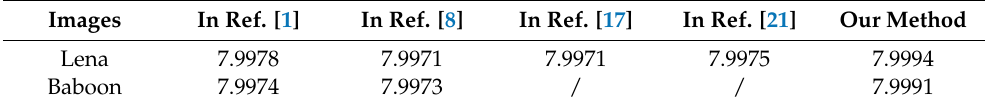
Table 6. The entropy analysis.